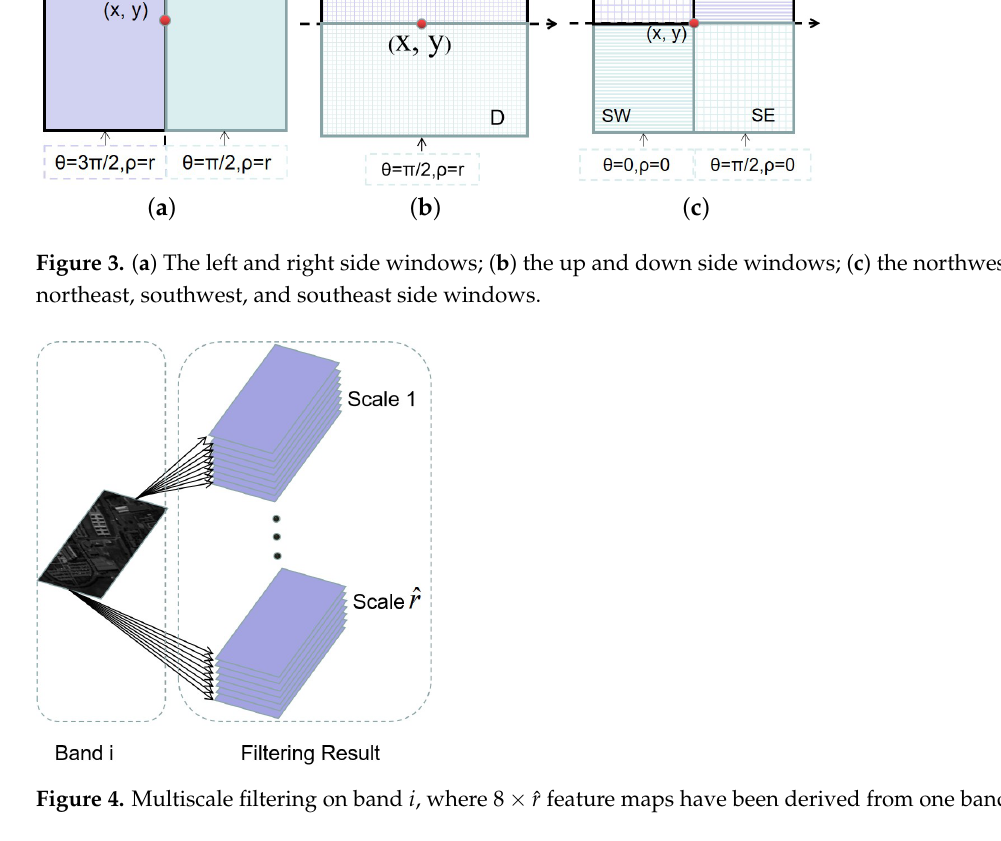
where ˆ F stands for filtering operation, r j is the radius of the window, and j = 1, 2, . . . ˆ r (ˆ r is the total number of the radius). Here, different r j corresponds to different scales. On each scale, eight side windows ( L , R , U , D , SW , SE , NE , NW denoted in Figure 3) have